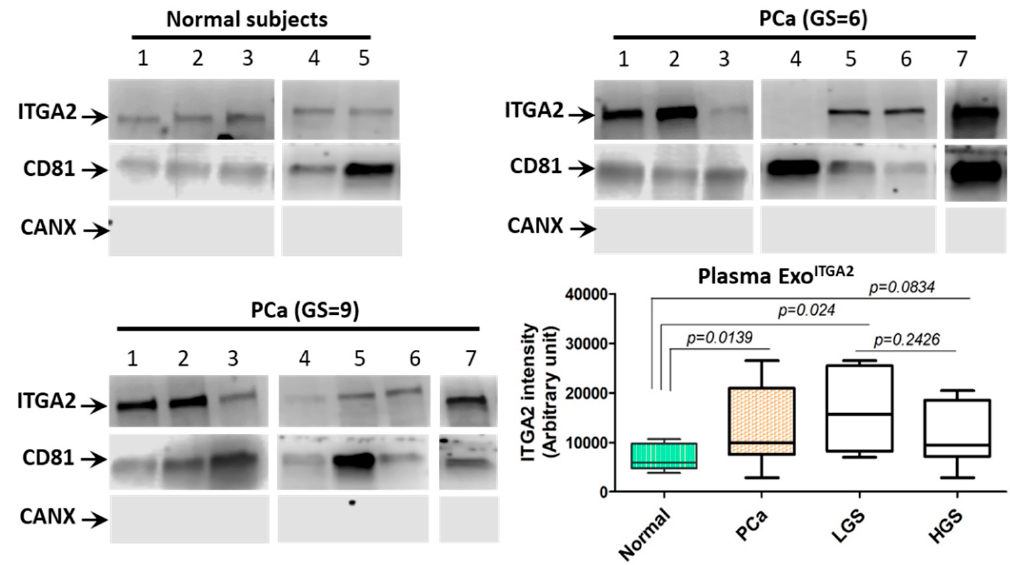
Figure 7. Expression of ITGA2 in exosomes isolated from plasma collected from PCa patients. ( A ) Exosomes were isolated from plasma of 14 PCa patients in addition to five healthy subjects. Exosomal protein lysates were prepared and immunoblot analysis was performed using anti-ITGA2, anti-CD81, and anti-Calnexin antibodies. The original immunoblots are provided in the Supplementary Materials. ( B ) Quantification of ITGA2 enriched in exosomes isolated from plasma of PCa patients and healthy subjects as a control group.